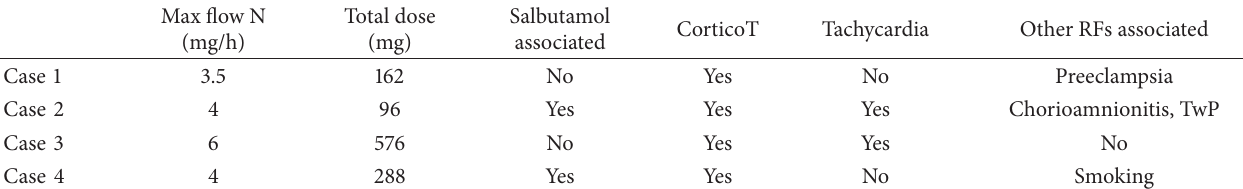
Table 2: Tocolytic treatment modalities and APE risk